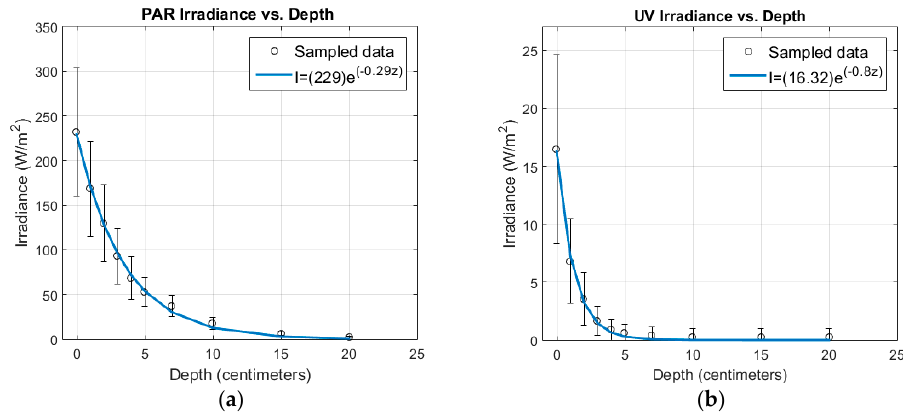
Figure 4. Light attenuation as a function of depth in the Pond Inlet WSP. ( a ) Spatial and temporal average of attenuation of PAR irradiance; ( b ) spatial and temporal average of UV irradiance. The concentrations of E. coli , other coliforms and total coliforms in the influent and effluent are